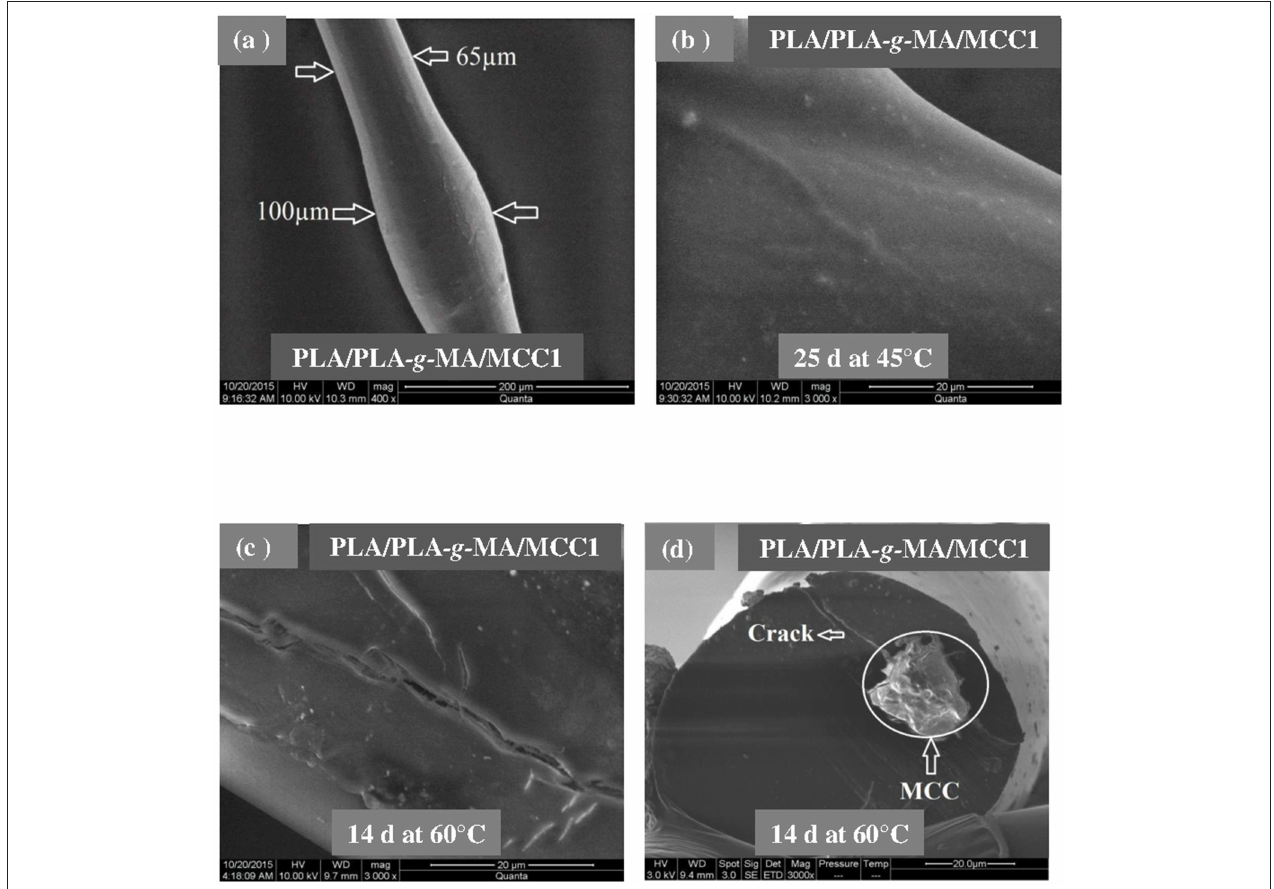
FIGURE 4 | SEM micrographs of external surface of a PLA/PLA -g- MA/MCC1 fiber. (a) Before exposure, (b) after 25 days at 45 ◦ C, (c) after 14 days at 60 ◦ C, and (d) SEM micrograph of cross-sectional surface of a PLA fiber after 14 days at 60 ◦